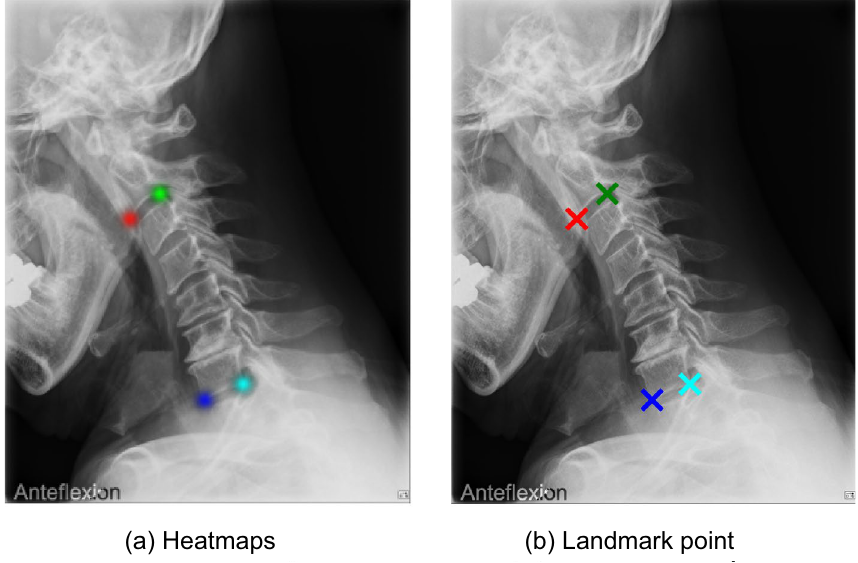
Figure 1. Most x-ray had a description of the posture in the corner of the x-ray. Anatomic landmark localization is done by extracting the coordinates with the maximum value from the heat map ( a ) of each landmark ( b ) output by the convolutional neural